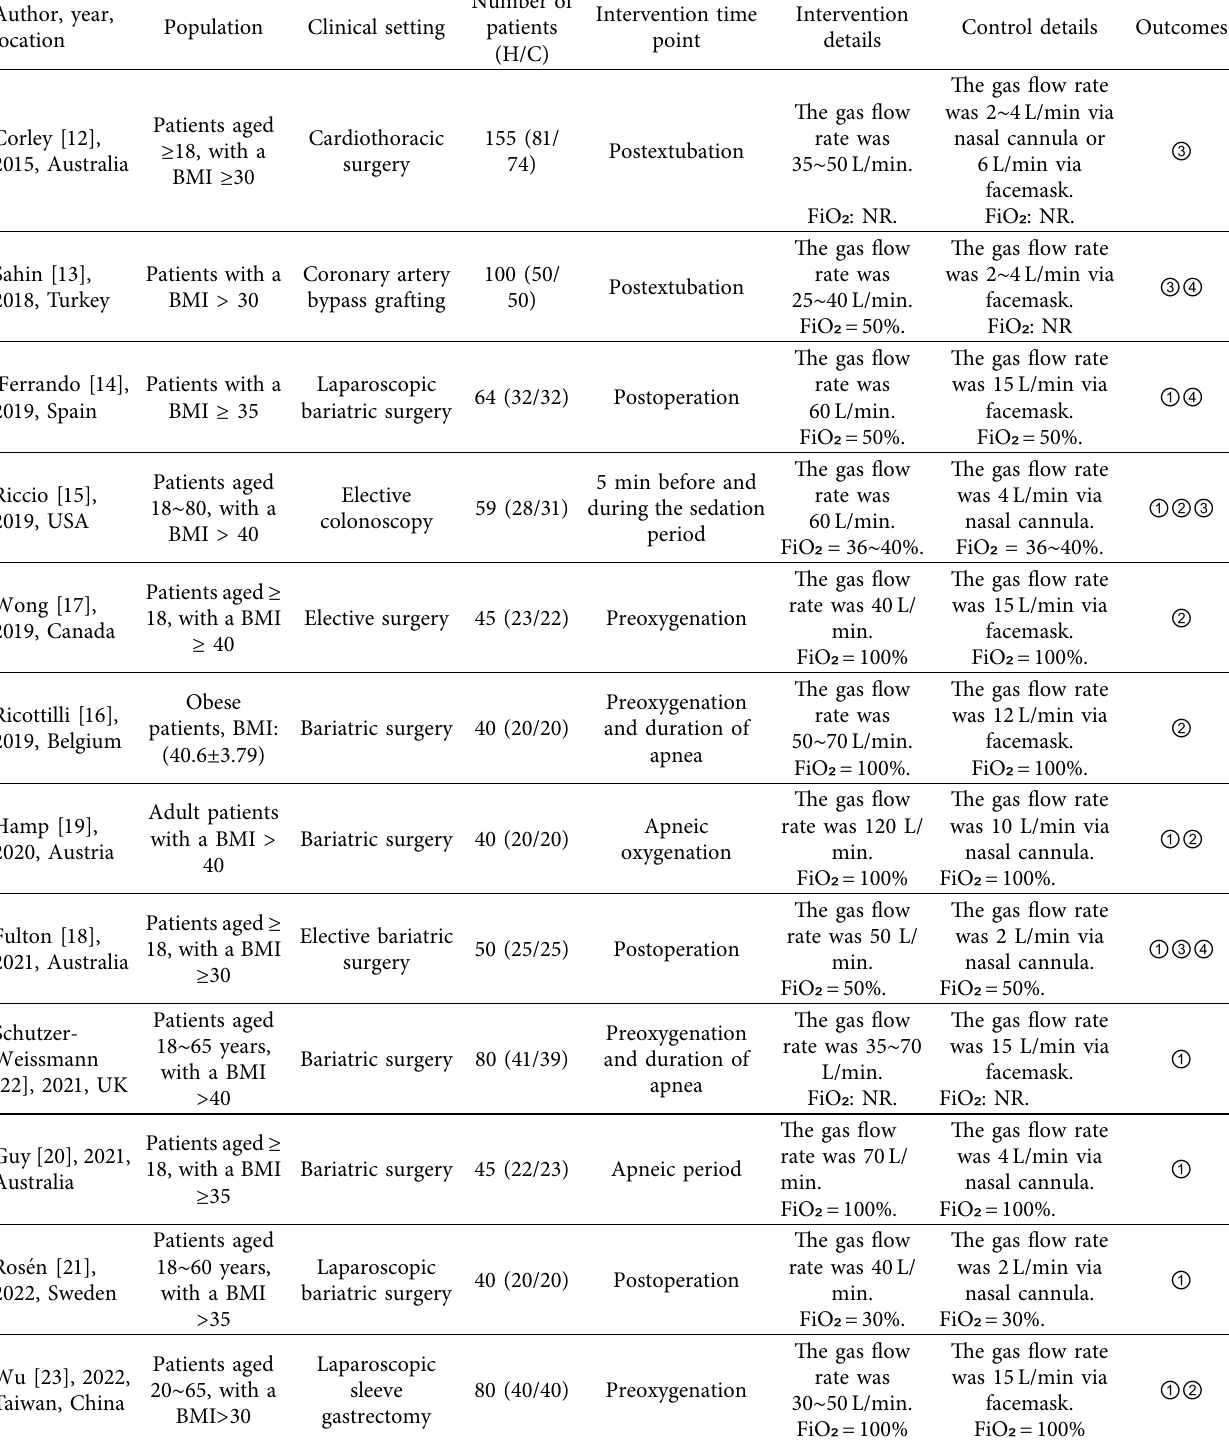
Table 1: Basic characteristics of the included clinical